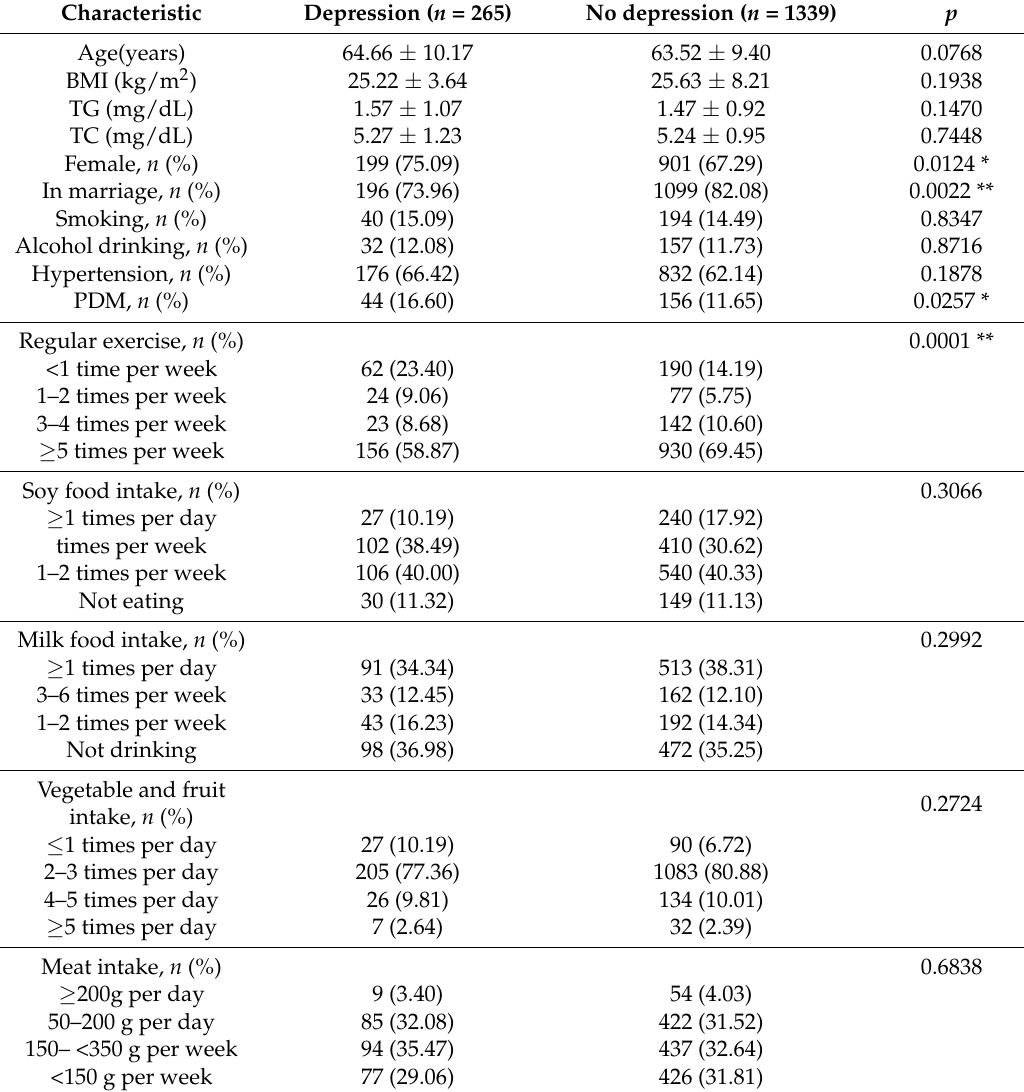
Table 2. Summary statistics and comparison of characteristics according to depression (means ±